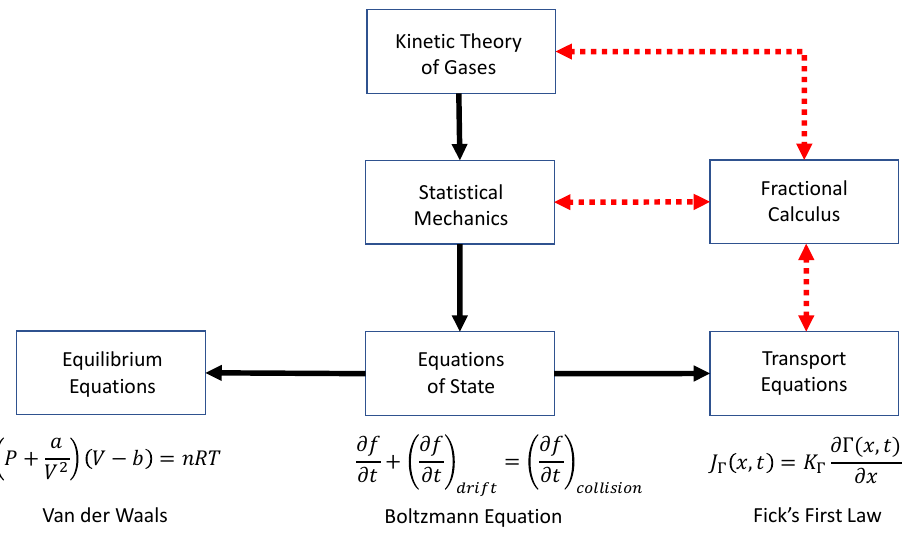
Figure 1. Block diagram illustrating the central role kinetic theory plays in formulating the thermody- namic description of matter. Kinetic theory underlies the derivation of the equations of state (e.g., van der Waals equation) and the transport of mass, momentum, and energy in gases and liquids. It is supported by statistical mechanics (and quantum mechanics) through a nested series of kinetic theory equations (Boltzmann, Fokker–Planck, Langevin). Fractional calculus influences this paradigm by incorporating non-integer time- and space-derivatives into models of inelastic collisions, Fick’s first law linking molecular flux to gradients in velocity, temperature, concentration, material porosity, and tortuosity, as well as predicting fluid behavior near the critical